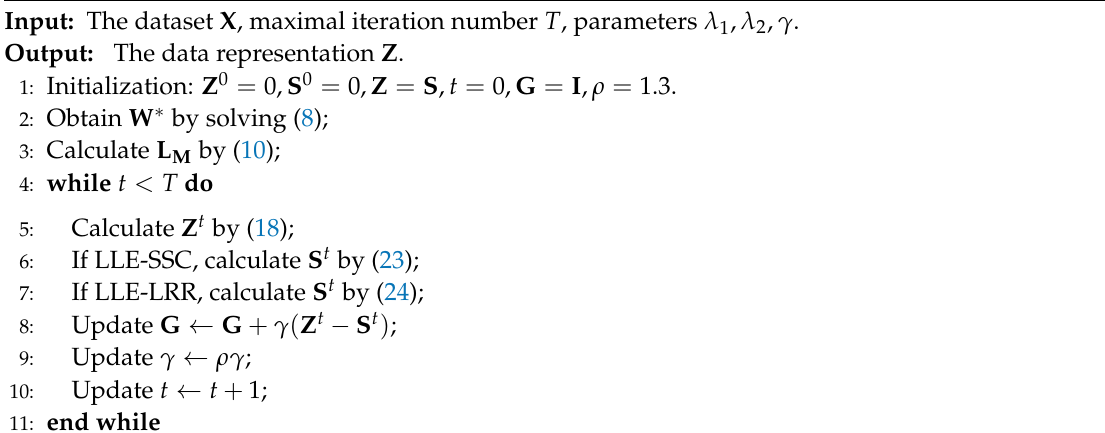
Algorithm 1 Solution to the data representation for LLE-SSC and LLE-LRR.